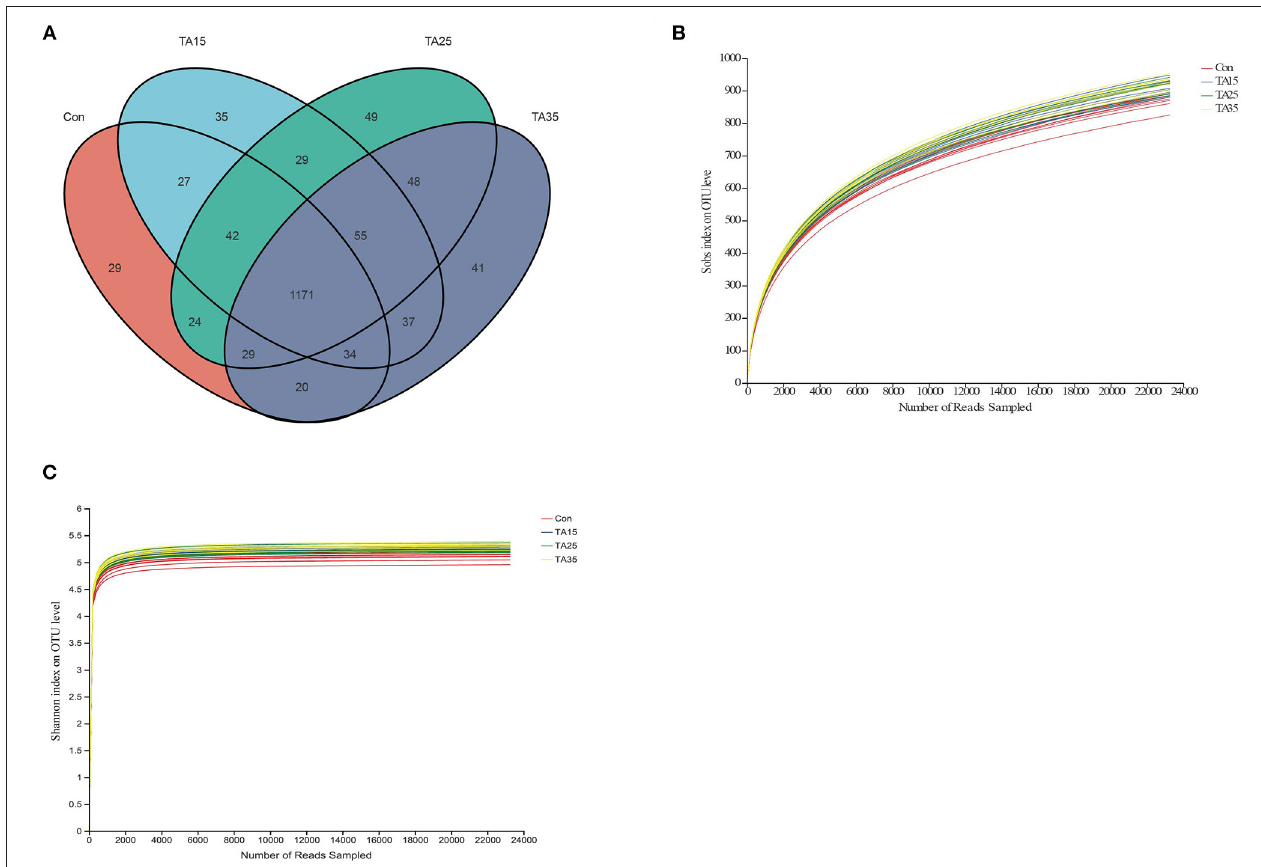
FIGURE 1 | Ruminal microbial operational taxonomic units (OTUs) among different groups. CON, corn steeped in water; TA15, corn steeped in tannic acid solution of 15 g/l; TA25, corn steeped in tannic acid solution of 25 g/l; TA35, corn steeped in tannic acid solution of 35 g/l. (A) Venn diagram of ruminal bacterial OTUs. (B) Bacterial rarefaction curves and (C) Shannon curves based on OTUs used to assess the depth of coverage for each sample.